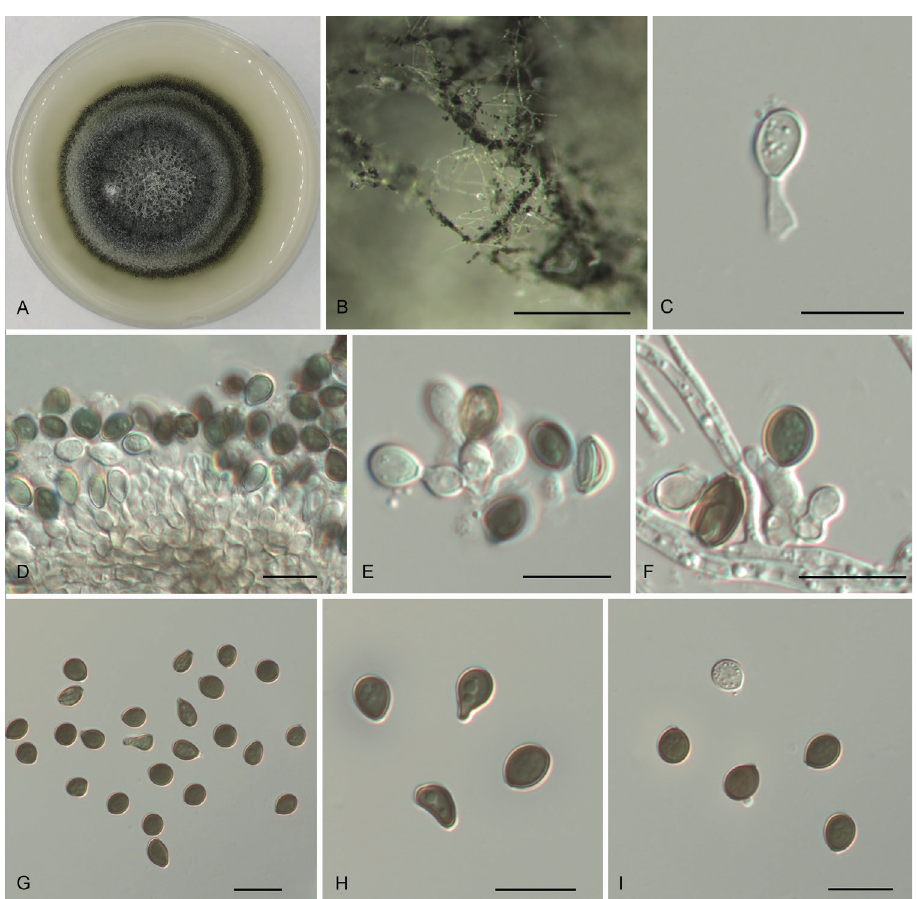
Figure 2. Neoarthrinium lithocarpicola A colony on PDA B conidiomata formed in culture C–F conid- iogenous cells giving rise to conidia G–I conidia. Scale bars: 500 μm ( B ), 10 μm ( C–I